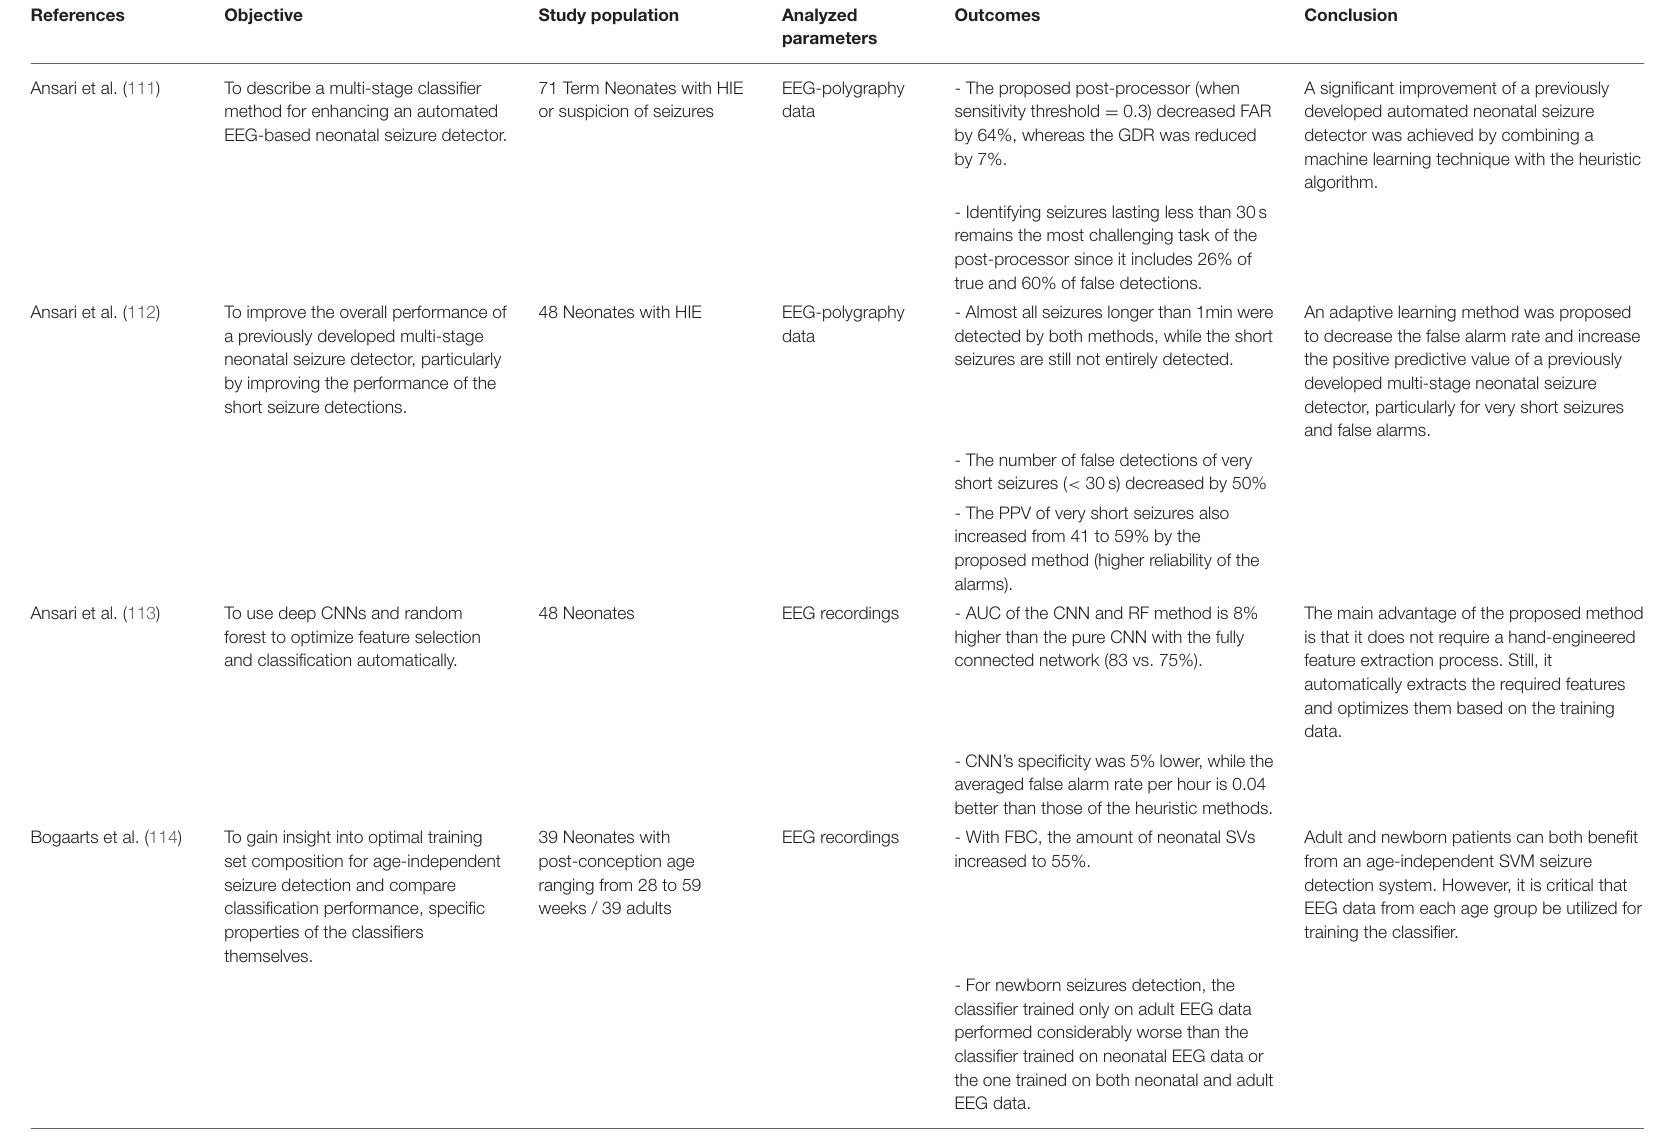
TABLE 2 | List of studies using ML for automated seizure detection published in the last 5